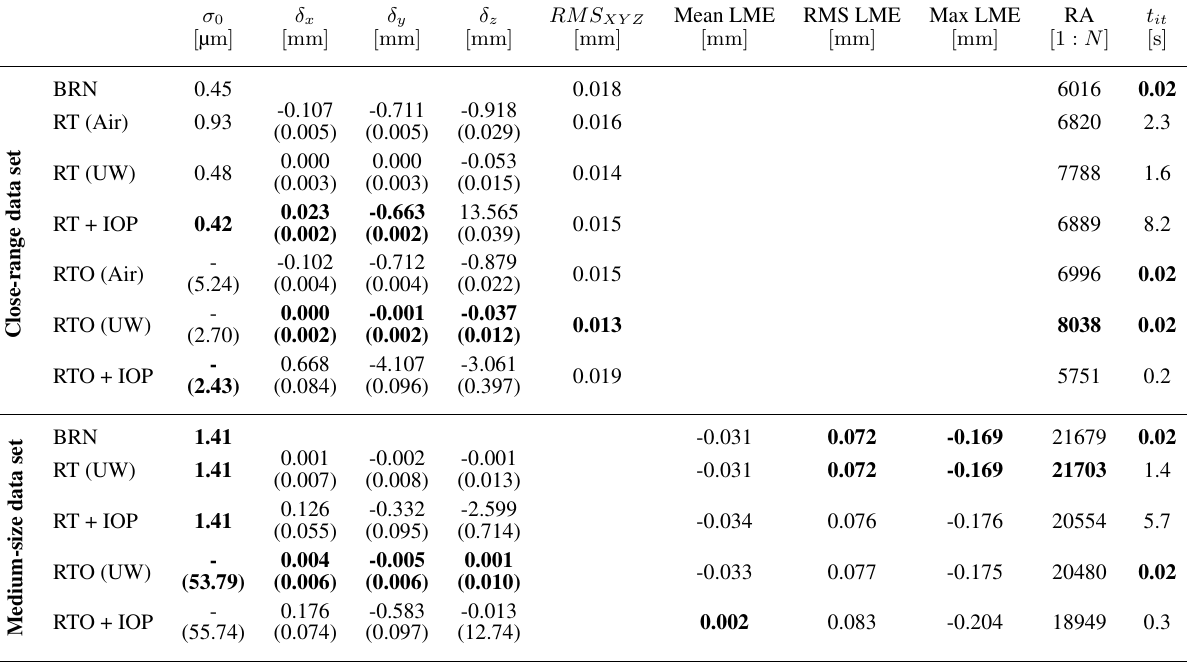
Table 3. Real data set results for Brown (BRN) and both ray tracing (RT/RTO) methods. Bracketed σ 0 for RTO shows standard deviation (SD) in object space. δ xyz are the respective dome offsets with bracketed SD below. RA is the relative accuracy, t it represents the time for a single iteration. Bold entries have highest accuracy or lowest computation time per column and data